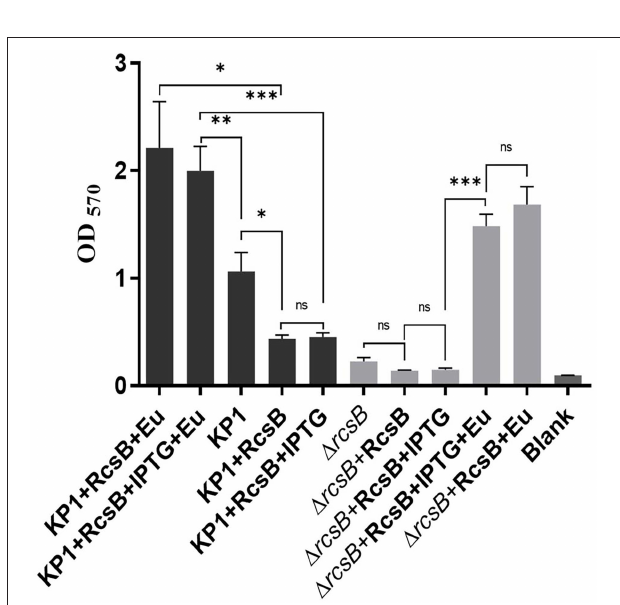
FIGURE 3 | Effect of eugenol on biofilm formation. The *, **, and *** denotes P < 0.05, P < 0.01, and P < 0.001 respectively.